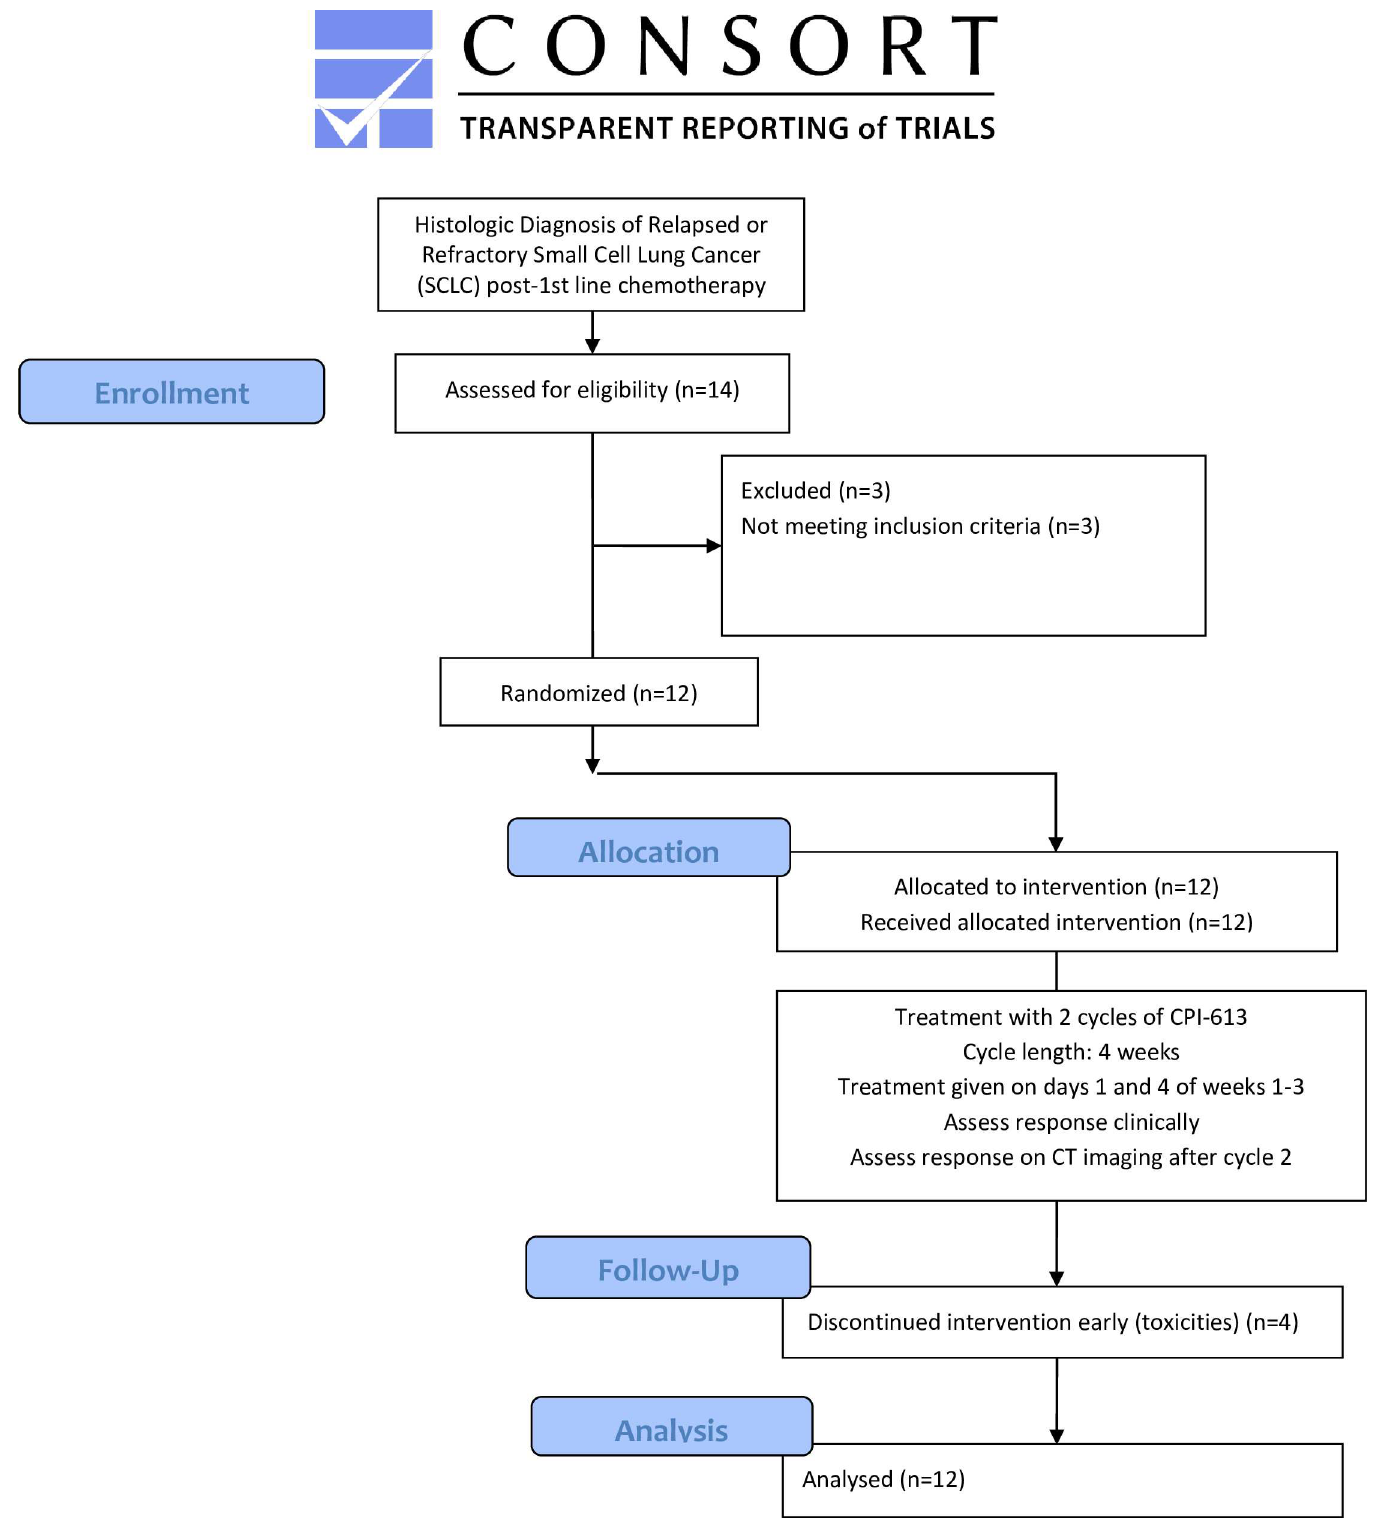
Fig 1. Flow diagram of study protocol.